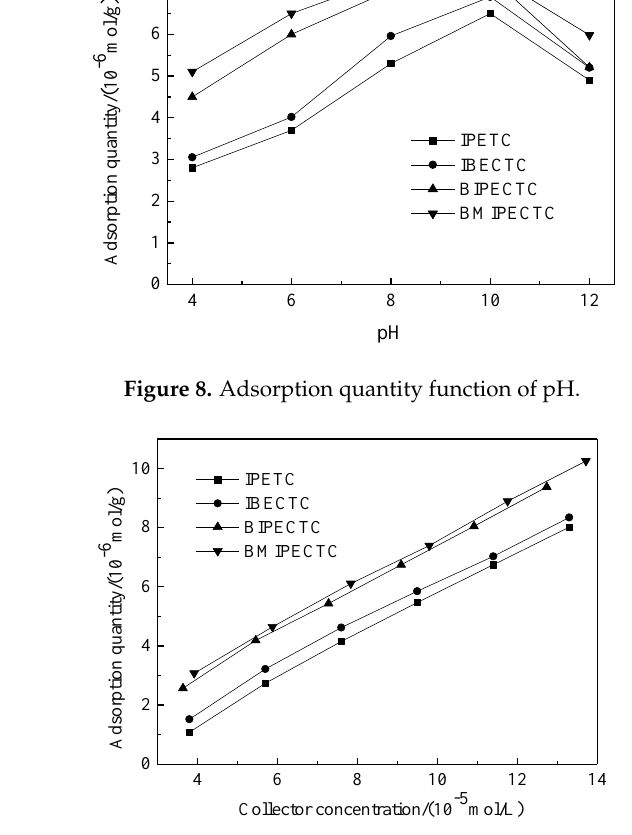
Figure 9. Adsorption quantity as a function of the collector concentration (pH = 9).